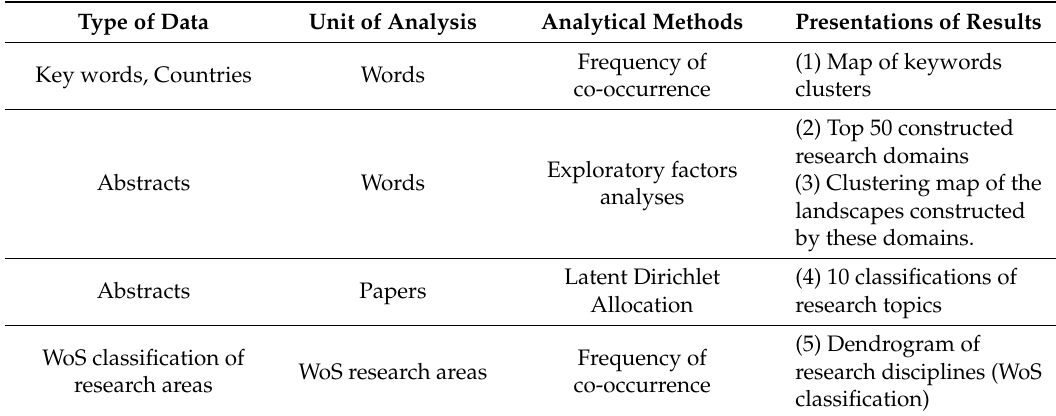
Table 1. Type of data and analytical